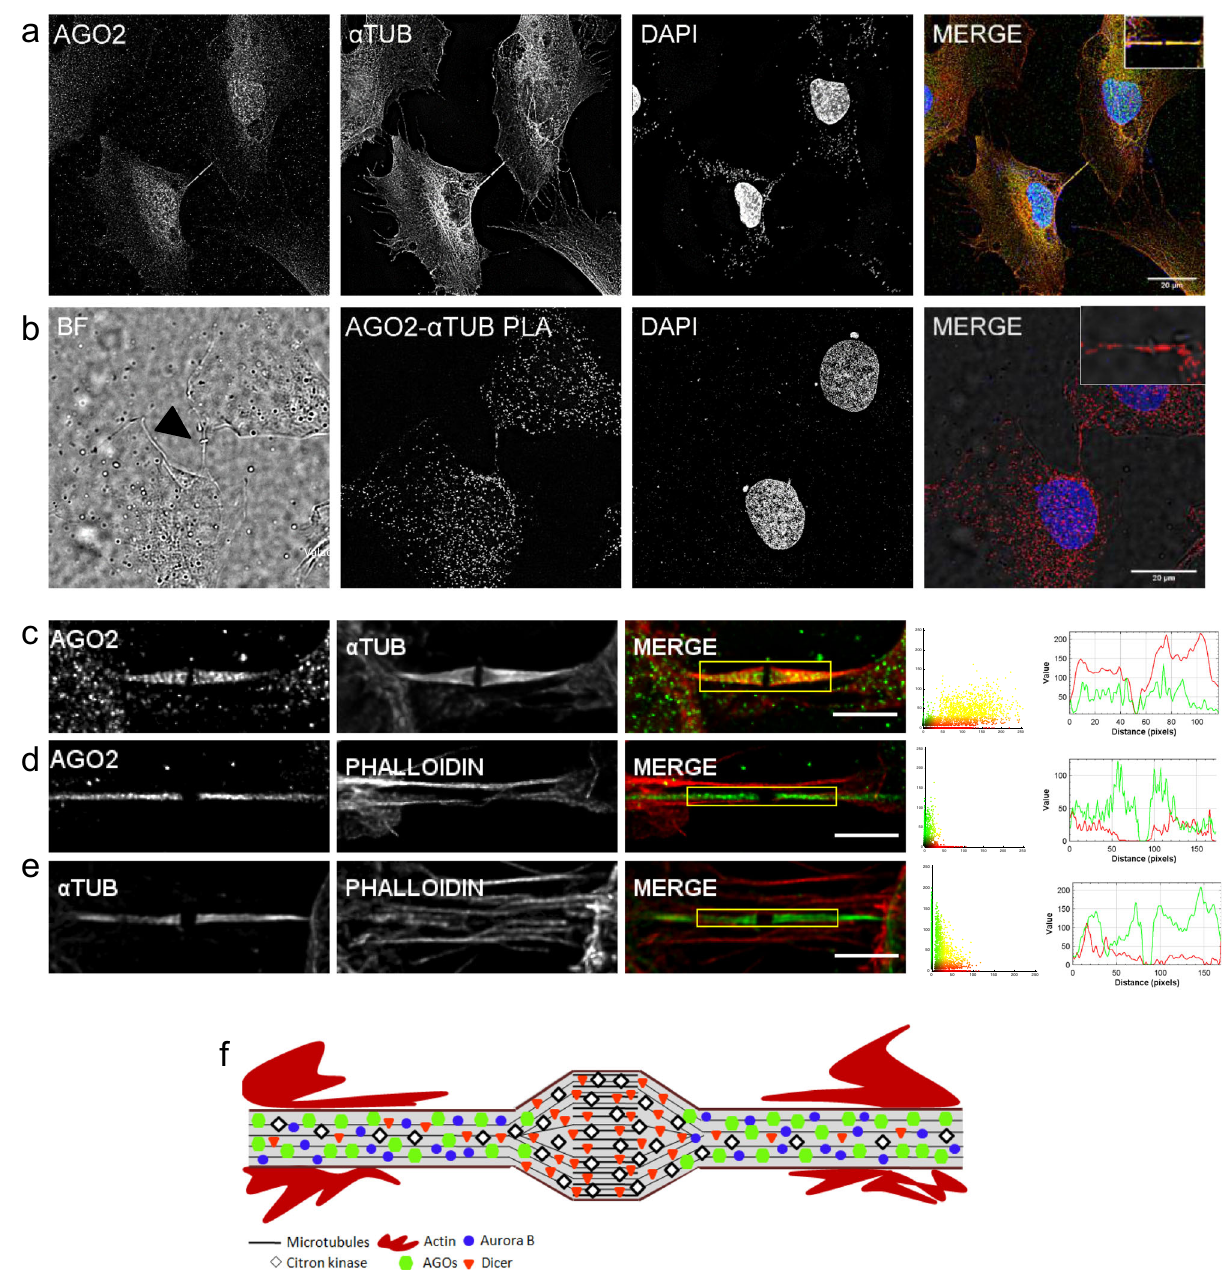
Fig. 4 AGO2 colocalizes with α -Tubulin in mitotic protrusions. a Representative immuno fl uorescence images of NTHY ori 3-1 cells depicting the colocalization of AGO2 (green) with α -Tubulin (red). Cell nuclei were stained blue (DAPI). b iPLA assays demonstrated the high proximity of AGO2 and α -Tubulin by the presence of red foci. The black arrowhead in the BF images indicates the midbody ring. The scale bar is 20 μ m. c – e Visual assessment (merged images, scatterplots, and intensity lineplots) of colocalization. Lineplots indicate the signal intensity of the paired proteins along the lines overlaid on the corresponding images that appear in Supplementary Fig. S4i – k. The colocalization metrics (Pearson [ R ] and Manders ’ [ M 1 and M 2] coef fi cients) and respective p values are presented in Supplementary Table S1. c , d AGO2 in green, α -Tubulin, and F-Actin (Texas red-phalloidin) in red. e α -Tubulin in green, F-Actin in red ( n = 6 biologically independent samples). f Diagrammatic representation of the components of the cytokinetic intercellular bridge including AGO2, Dicer, CITK, Aurora B, α -Tubulin, and F-Actin. Scale bar: 5 μ